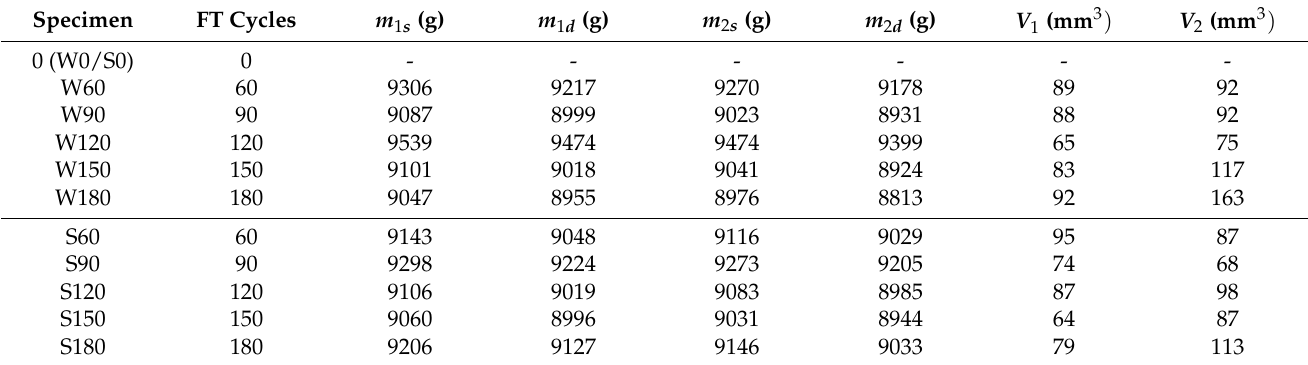
Table 3. Mass and solution-filled pore volume of notched beams subjected to freeze–thaw cycles.